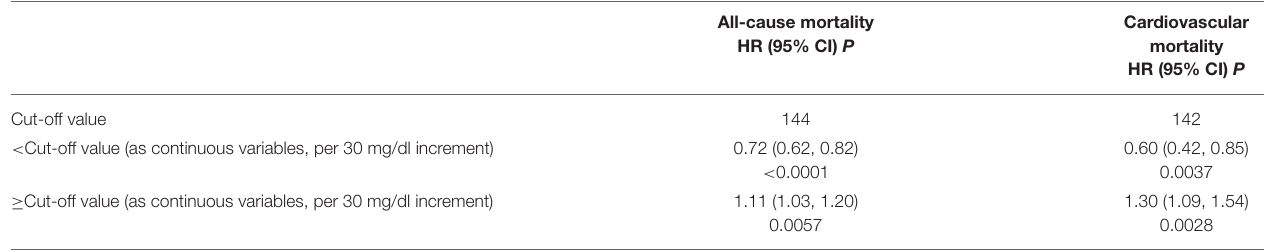
TABLE 3 | The results of two piecewise linear regression model of non-HDL-C with all-cause and cardiovascular